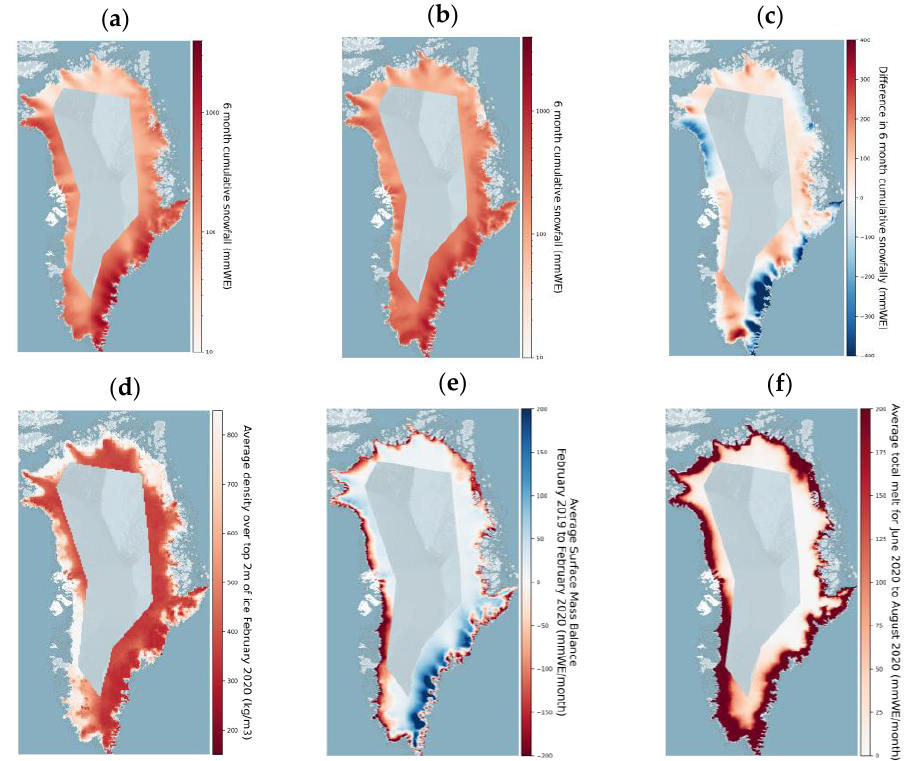
Figure 5. Spatial plots of MAR model outputs across GrIS for ( a ) cumulative snowfall in